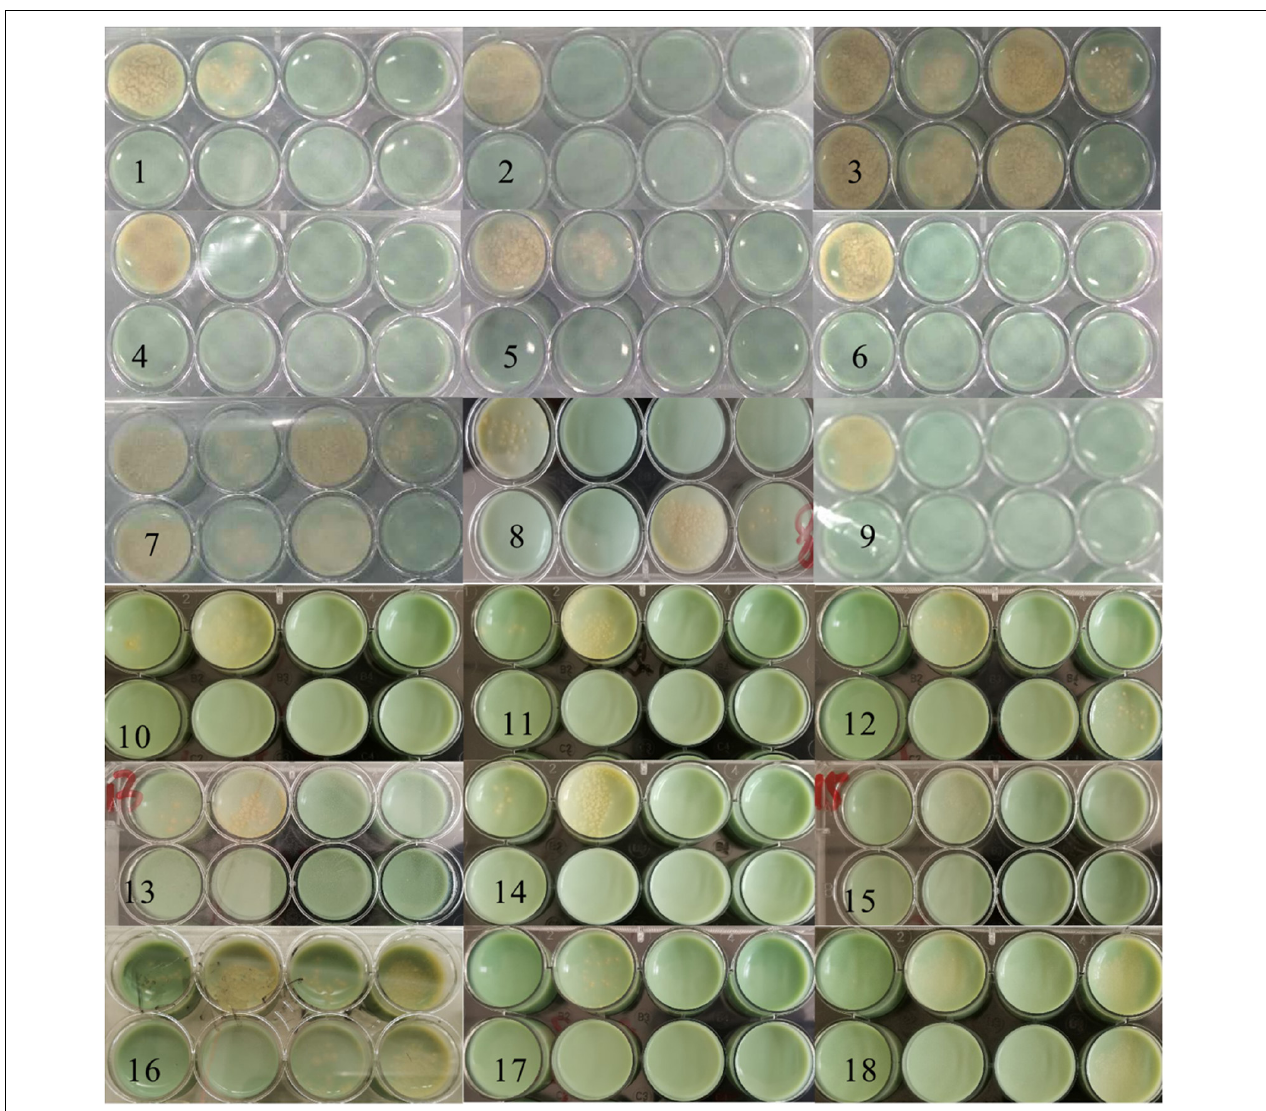
FIGURE 10 | Solid medium drug susceptibility testing of 8.0 µ g/ml CS-DHA NPs combined with anti-TB drugs ( n =